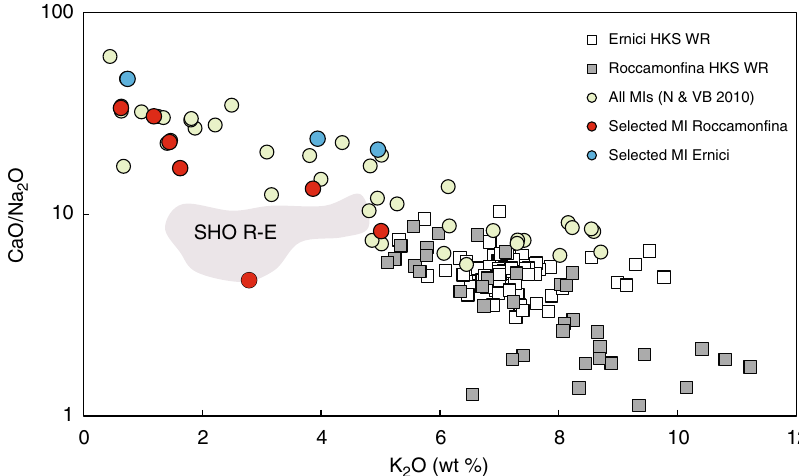
Fig. 2 K 2 O versus CaO/Na 2 O in HKS lavas and melt inclusions from Roccamon fi na-Ernici. A signi fi cant portion of the high Fo olivine-hosted melt inclusions suggests mixing with a component that has relatively high CaO/Na 2 O and low K 2 O. The red symbols indicate the subset of the melt inclusions selected for Sr-Nd-Pb isotope analyses to investigate the exotic mantle component. The bulk rock lava data 76 and fi eld for shoshonitic lavas at Roccamon fi na-Ernici 76 (SHO R-E) in grey is shown for comparison. The MI source data 23 are provided as a Source Data fi